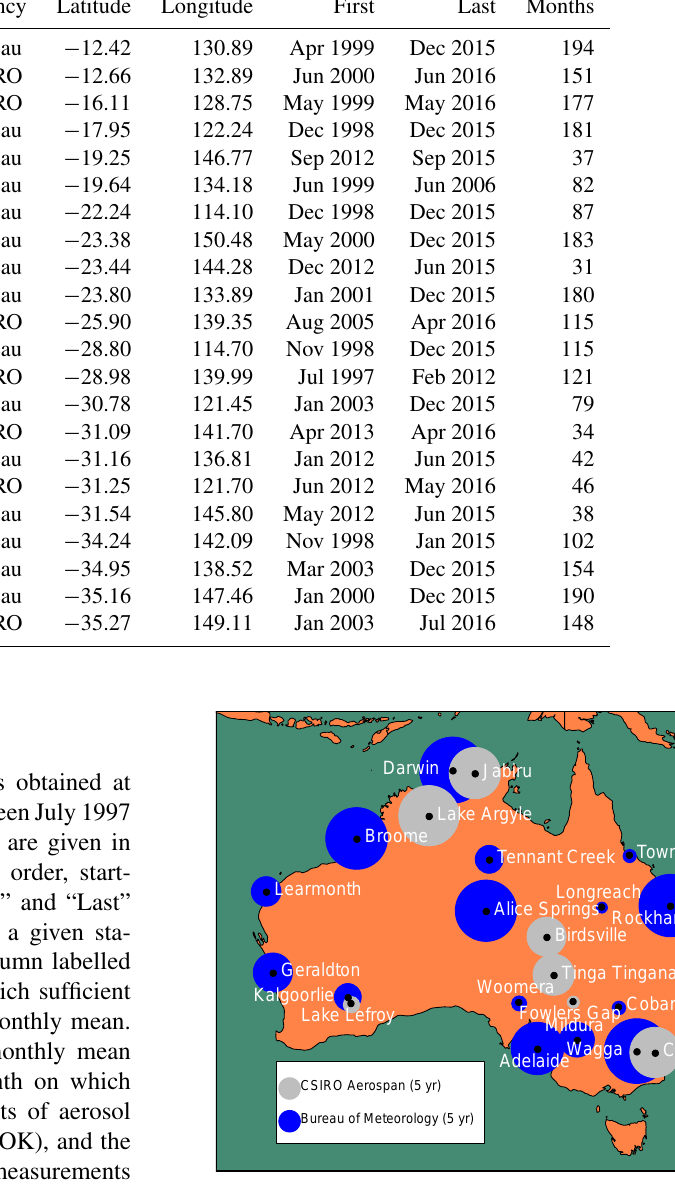
Figure 1. Location of sun photometer stations in Australia. Bureau of Meteorology stations are shown in blue, and CSIRO/AeroSpan stations in grey. The radius of the filled circles scales with the dura- tion of the data record at a given station. The filled circles shown in the legend are for a duration of 5